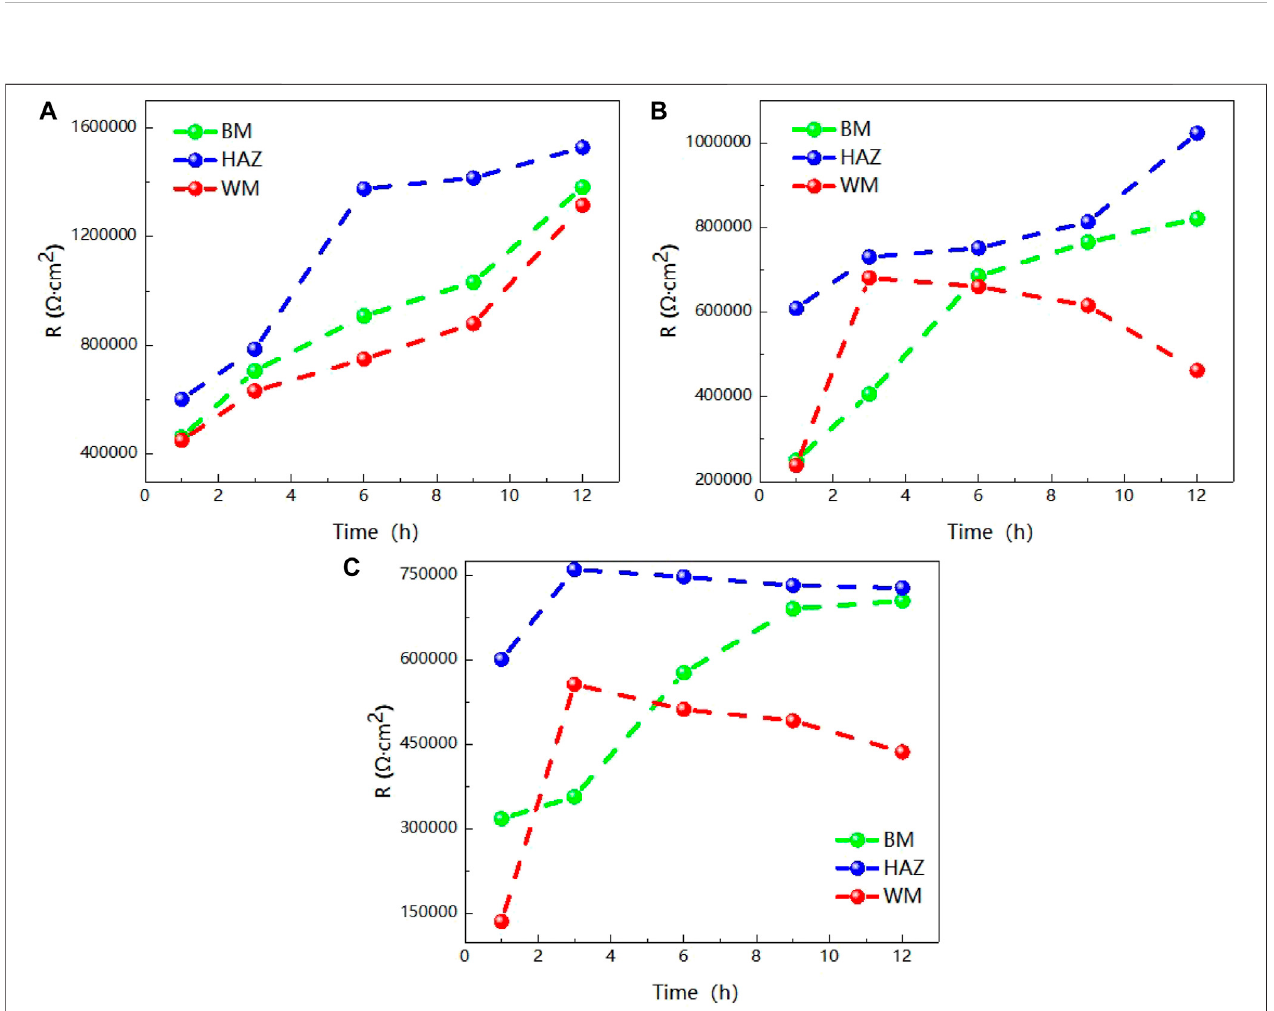
Frontiers in Chemistry |